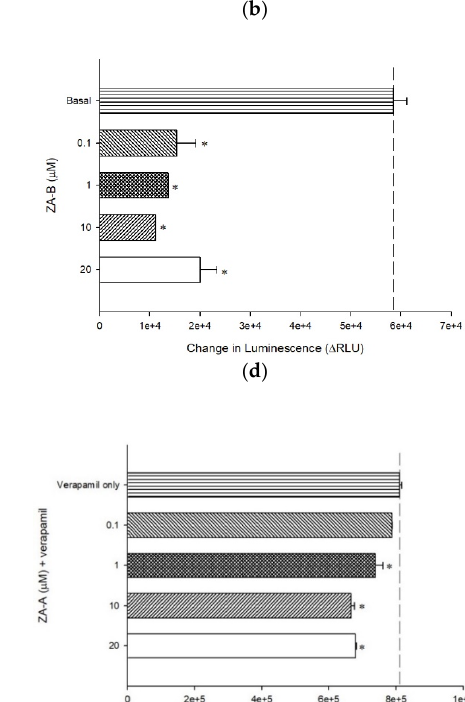
stimulated ATPase activity, indicating their negative regulating ability on ATPase function (Figure 3d–f).